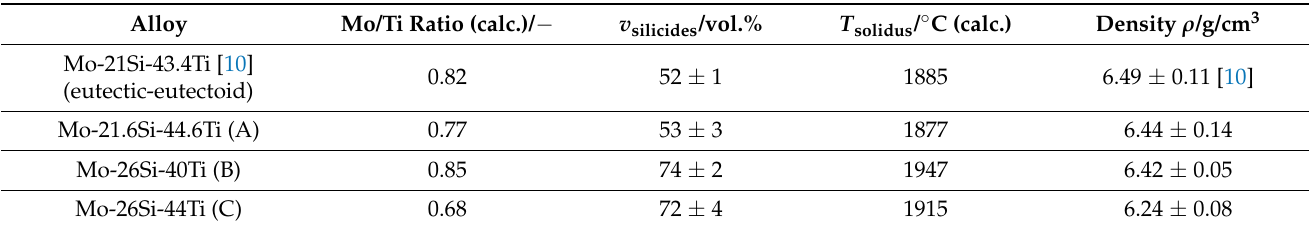
Table 1. Overview on the compositional, microstructural and physical features of the investigated alloys A to C in comparison to the eutectic-eutectoid reference alloy Mo-21Si-43.4Ti [10]. Calculated data are labelled by “calc.”; all other data were experimentally determined. The Mo/Ti ratio is calculated from the nominal alloy